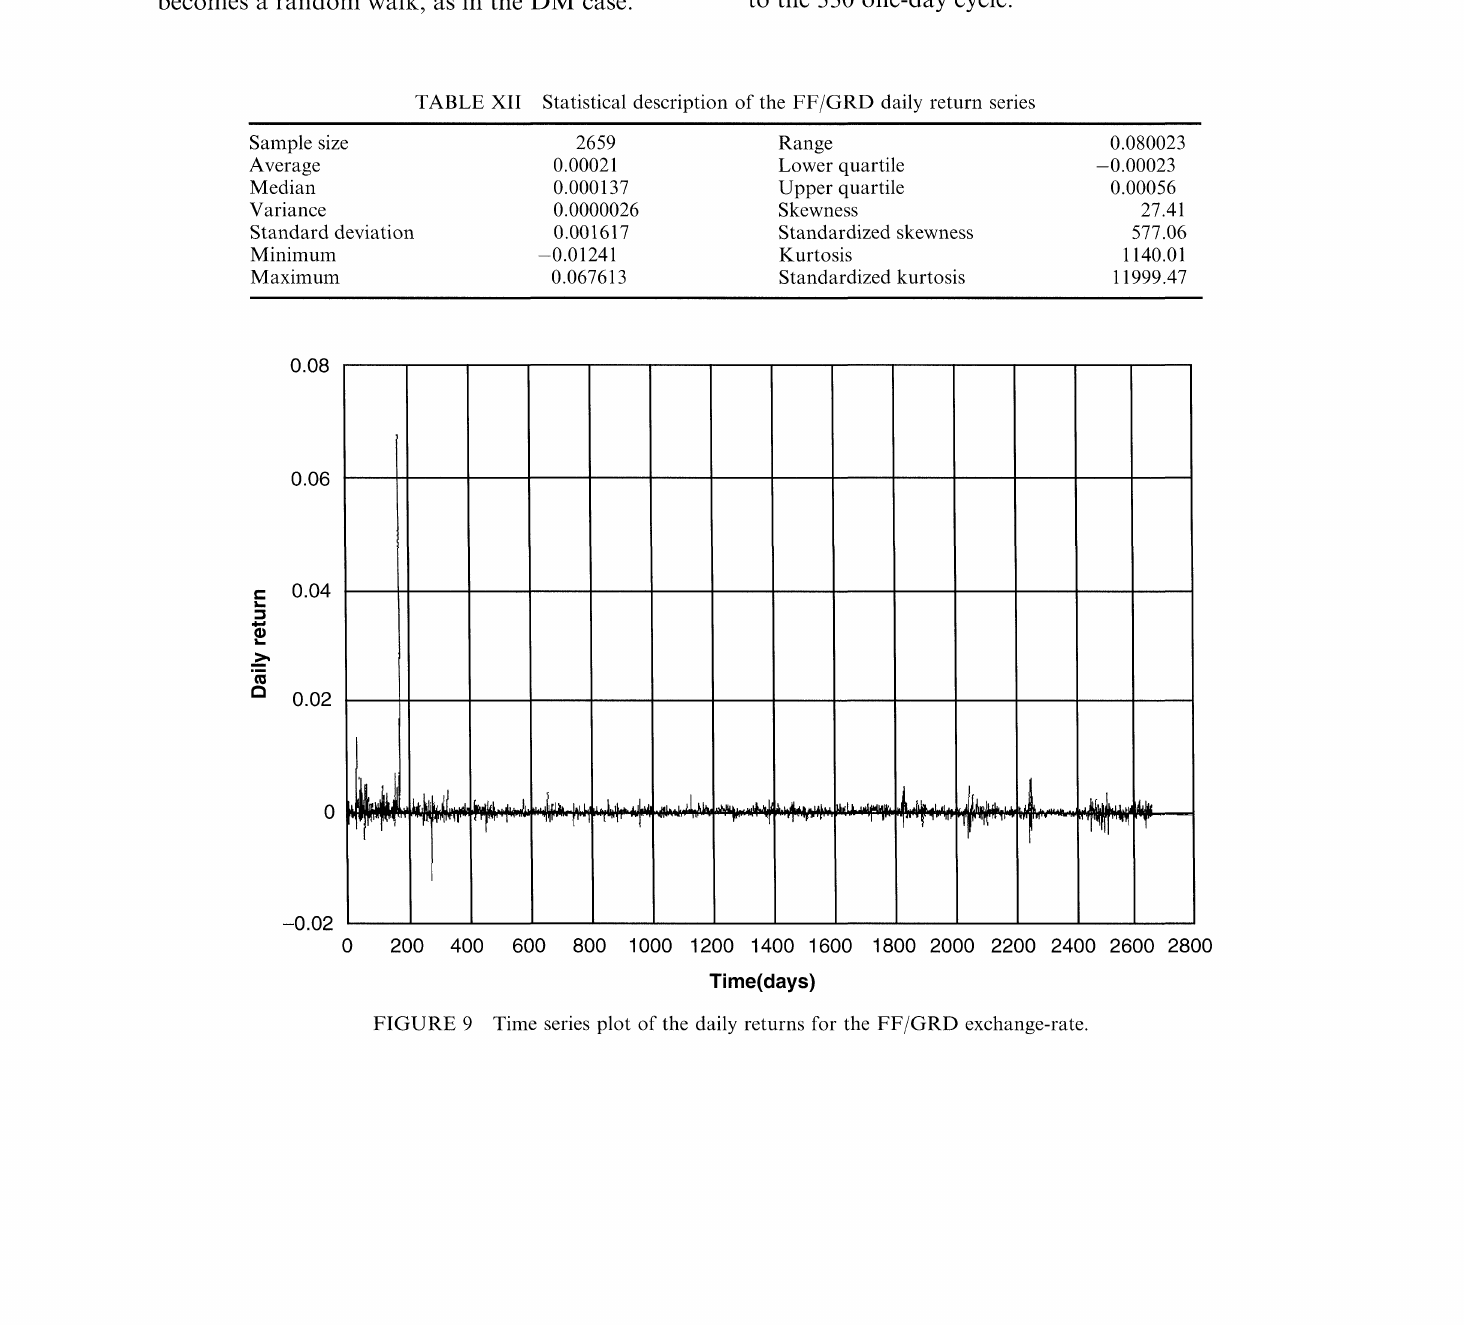
TABLE XII Statistical description of the FF/GRD daily return series